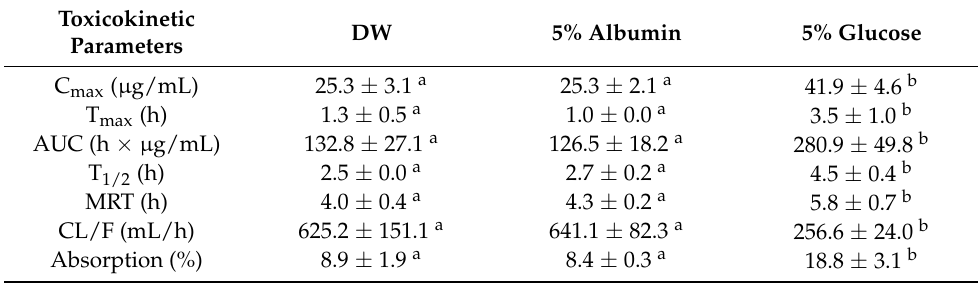
Figure 8. Effect of interactions between ZnO NPs and albumin or glucose on toxicokinetics of ZnO NPs after a single dose (100 mg/kg) oral administration in rats. Different lowercase letters (a,b) indicate significant differences among ZnO NPs interacted with DW, albumin, or glucose ( p < 0.05). * Significant differences compared with untreated control ( p < 0.05). Table 1. Toxicokinetic parameters and oral absorption after a single dose (100 mg/kg) oral administration of ZnO NPs interacted with DW, albumin, or glucose in rats.